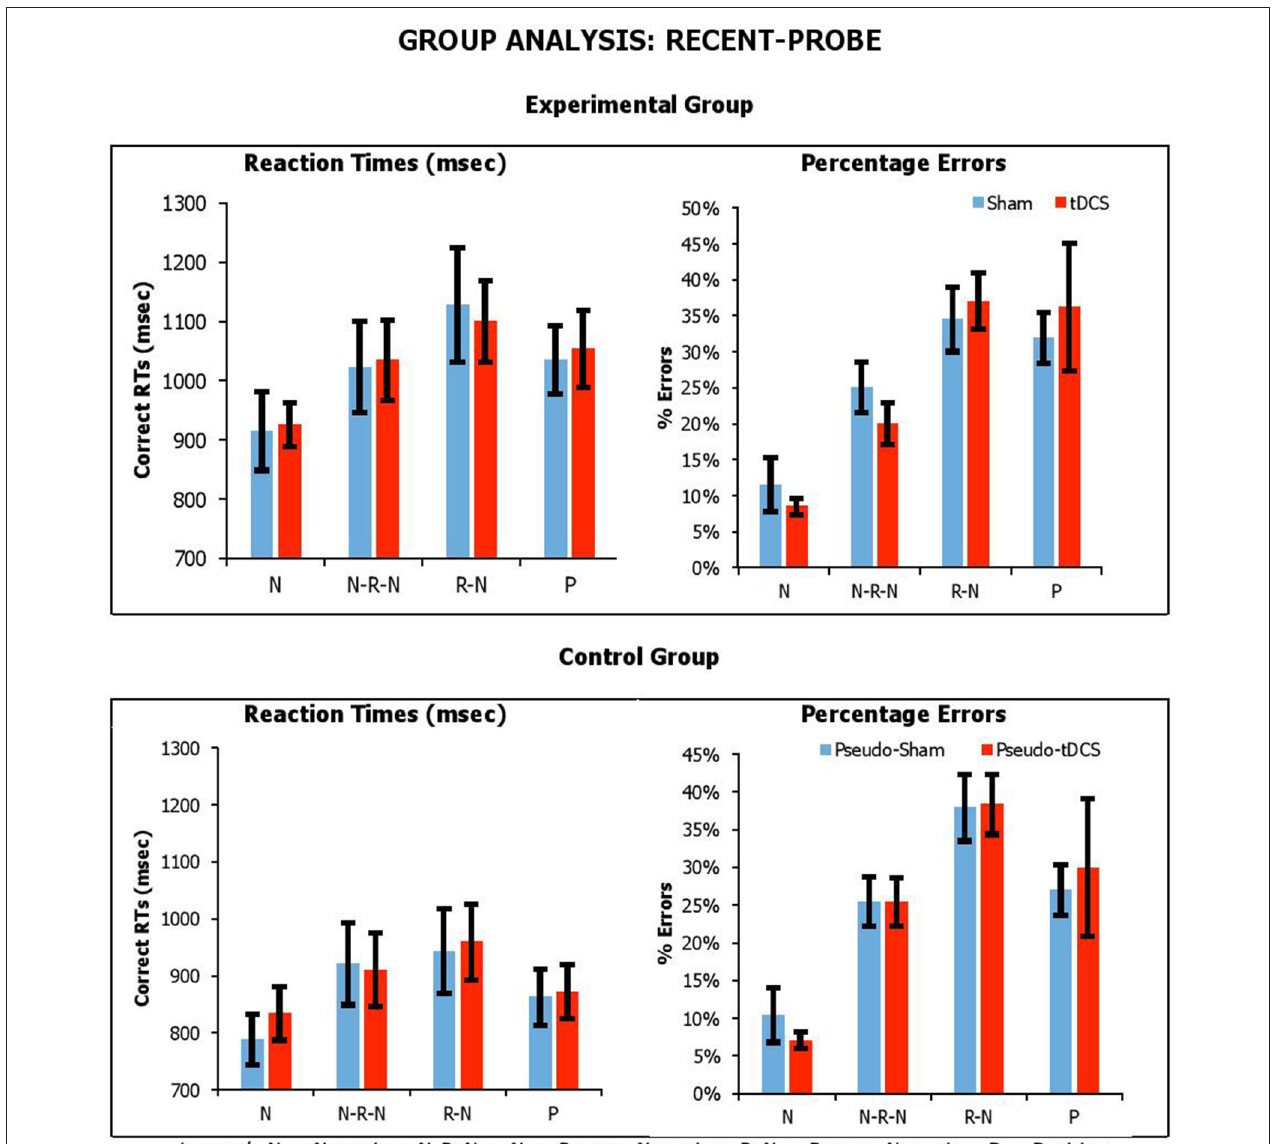
FIGURE 3 | Average correct RTs (ms) and percentages errors for recent-probe task across participant groups, probe conditions, and stimulation conditions. Error Bars indicate Standard Error.